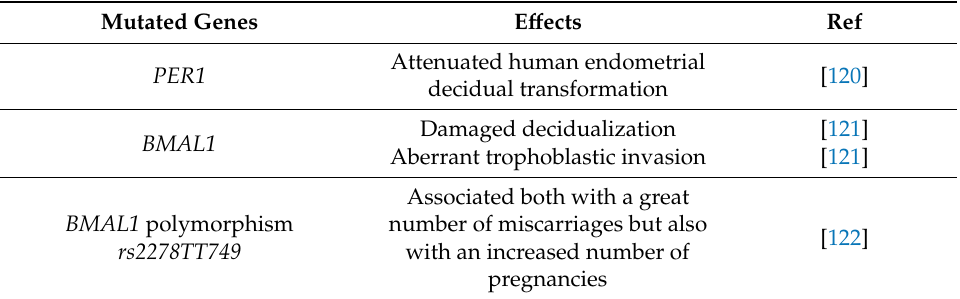
Table 4. E ff ect of mutated genes on human female